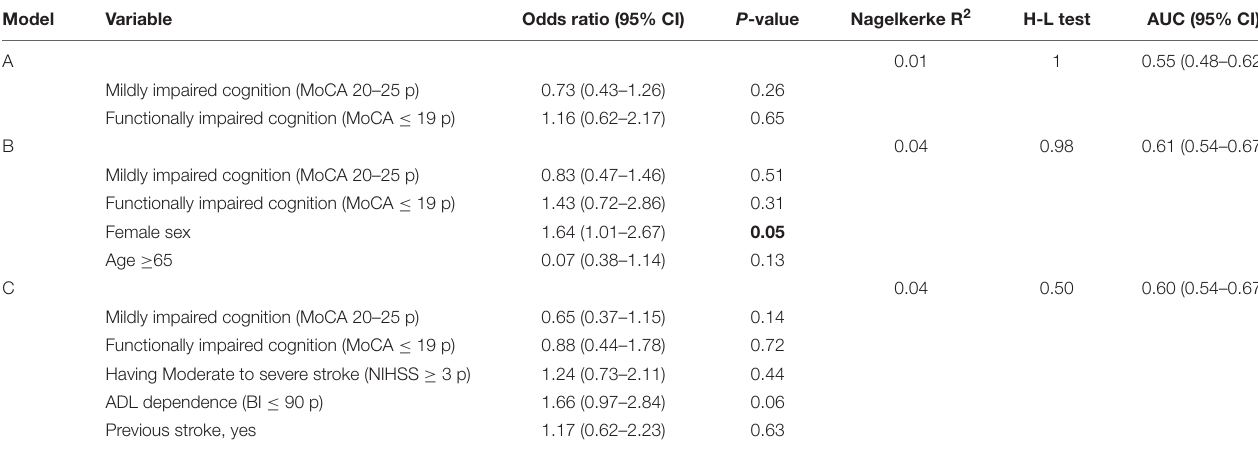
FIGURE 4 | Heat map showing the correlation coefficients ( P -values) between self-reported feeling of fatigue 3 months after stroke and baseline characteristics ( n = 311). Statistics were determined by the phi correlation coefficient for binary variables and Spearman correlation coefficient for ordinal variables. Bold text indicates significant results. * p < 0.05 and ** p < 0.01. NIHSS, National Institutes of Health Stroke Scale; MoCA, Montreal Cognitive Assessment; BI, Barthel index. The MoCA and BI were obtained 36–48 h after admission to the stroke unit. TABLE 3 | Binary logistic regression analyses for explaining self-reported feeling of fatigue 3 months after